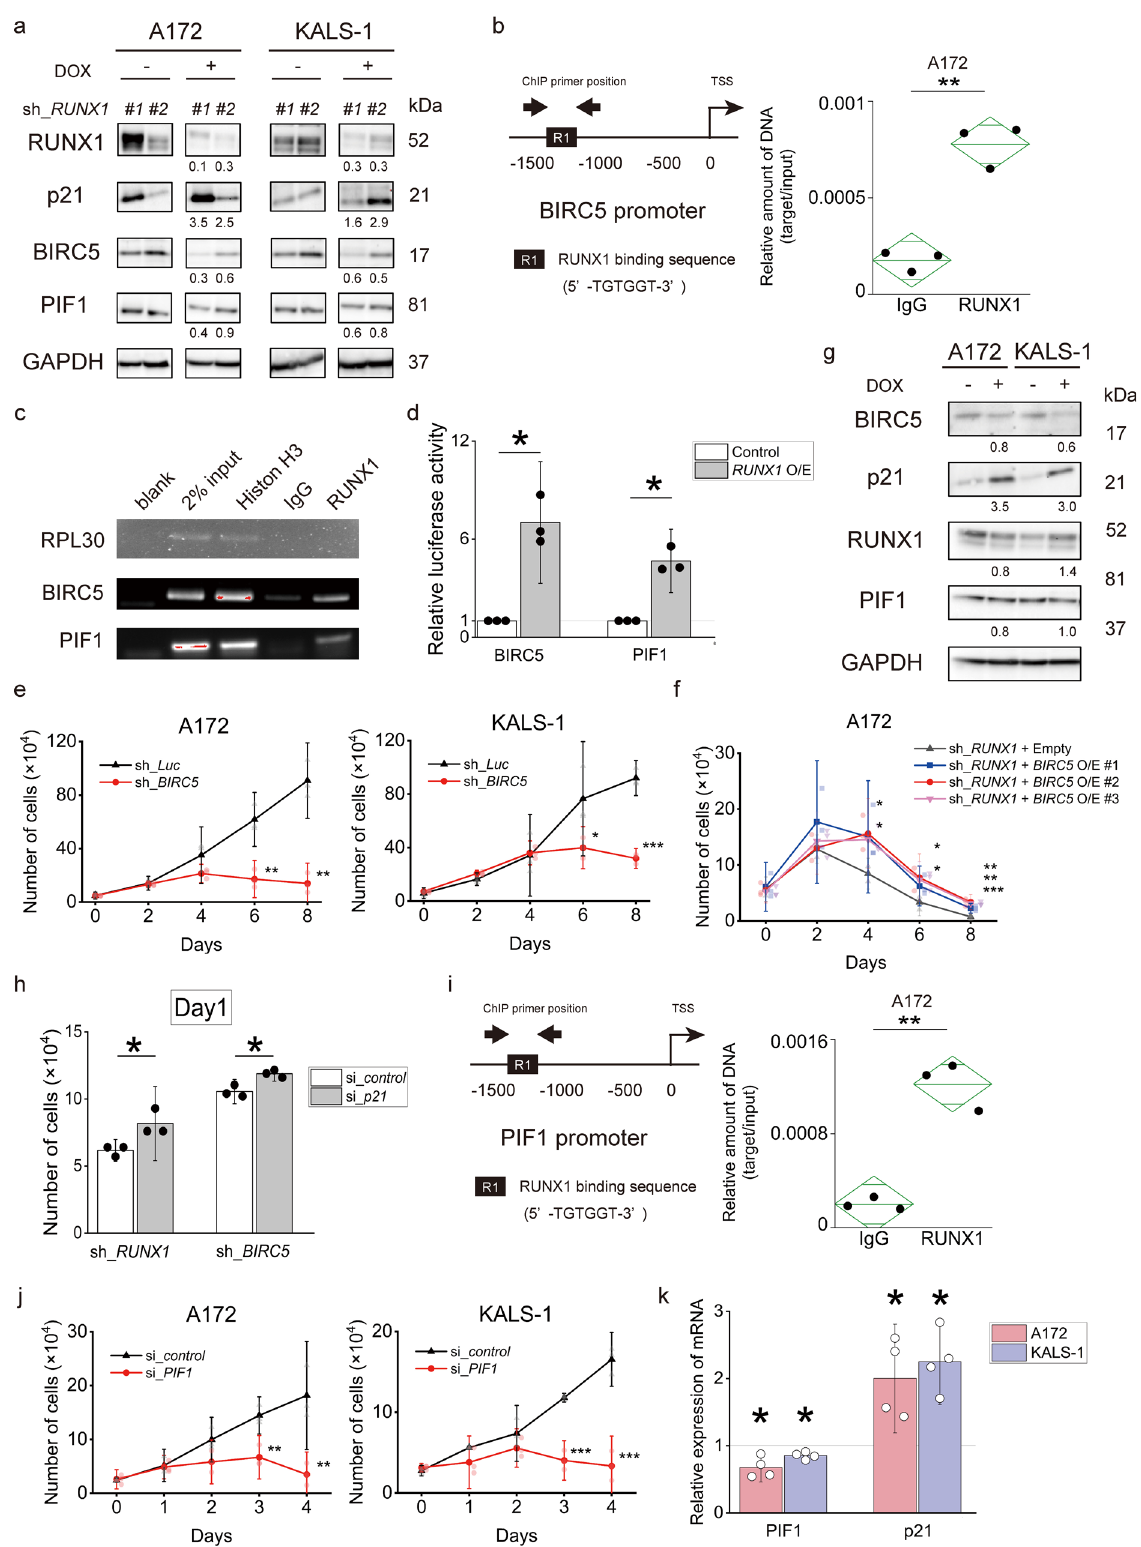
human DNA helicase with broad substrate speci fi city that has been implicated in genome stability. Required for DNA repli- cation, PIF1 is particularly important in humans. This